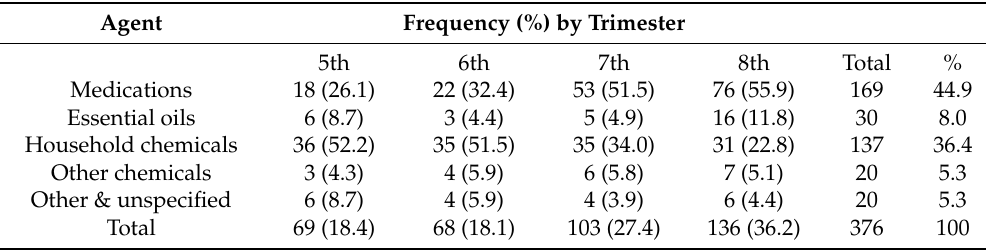
Table 5. Agents involved in poisonings of children aged one year admitted to hospital.